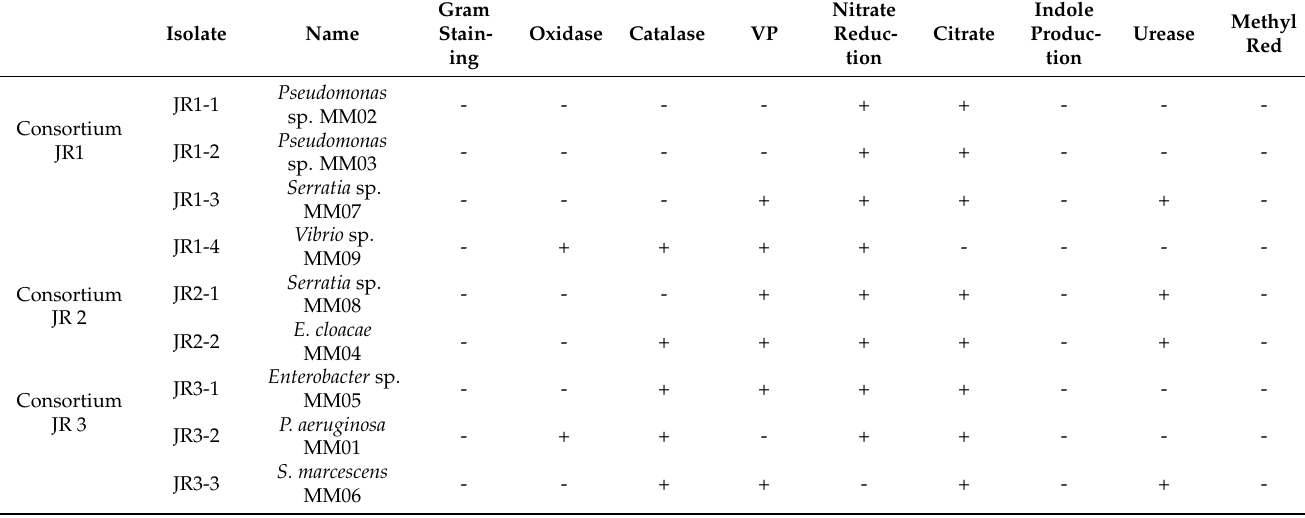
Table 5. Morphology and biochemical properties of the different isolates (+), strain positive; (-), strain negative.